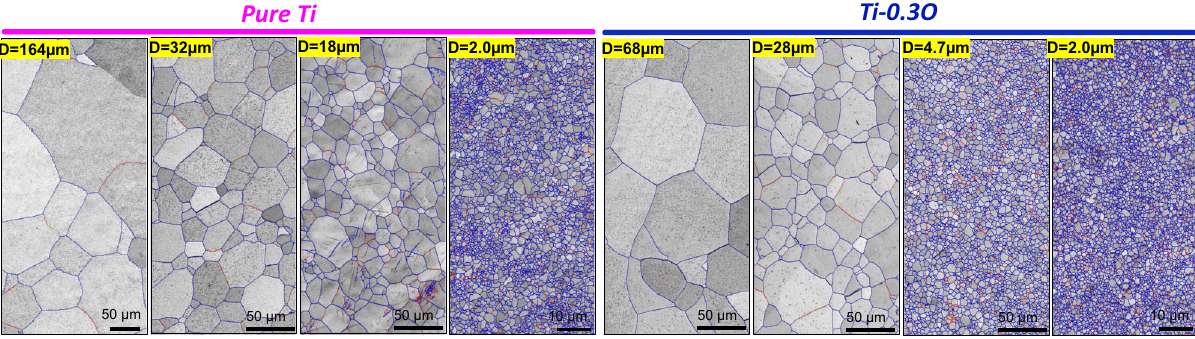
Fig.1|InitialmicrostructuresofpureTiandTi-0.3Oalloys. Representativegrain boundary maps (blue lines: high-anglegrainboundaries with misorientation angle, θ >15°,red lines: low-angle grainboundarieswith misorientation angle, 2° ˂ θ ≤ 15°)